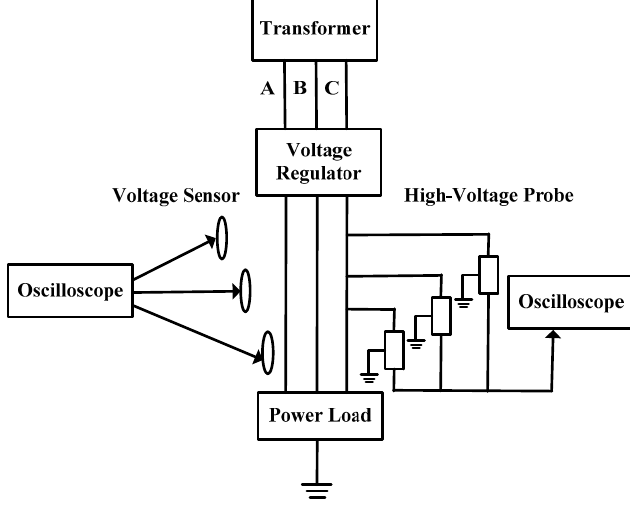
Figure 5. Structure of measurement system.